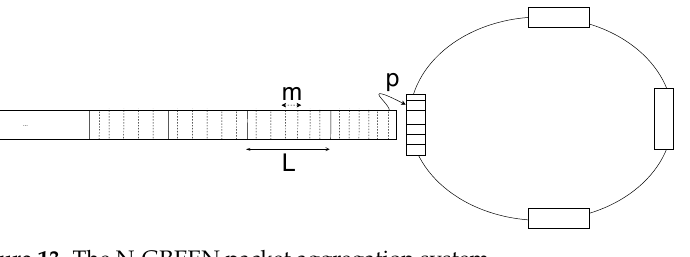
Figure 13. The N-GREEN packet aggregation